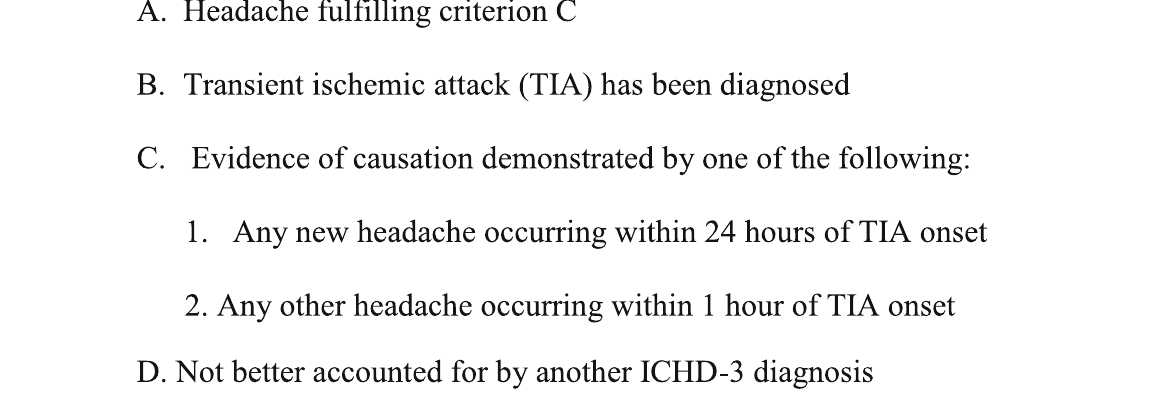
Fig. 2 New proposed diagnostic criteria for Headache Attributed to